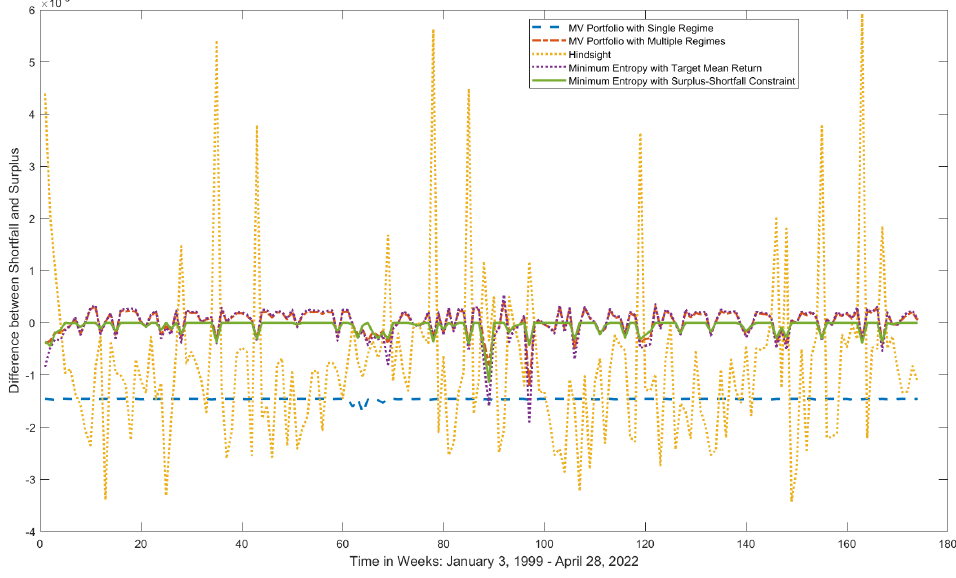
Figure 5. Constraint